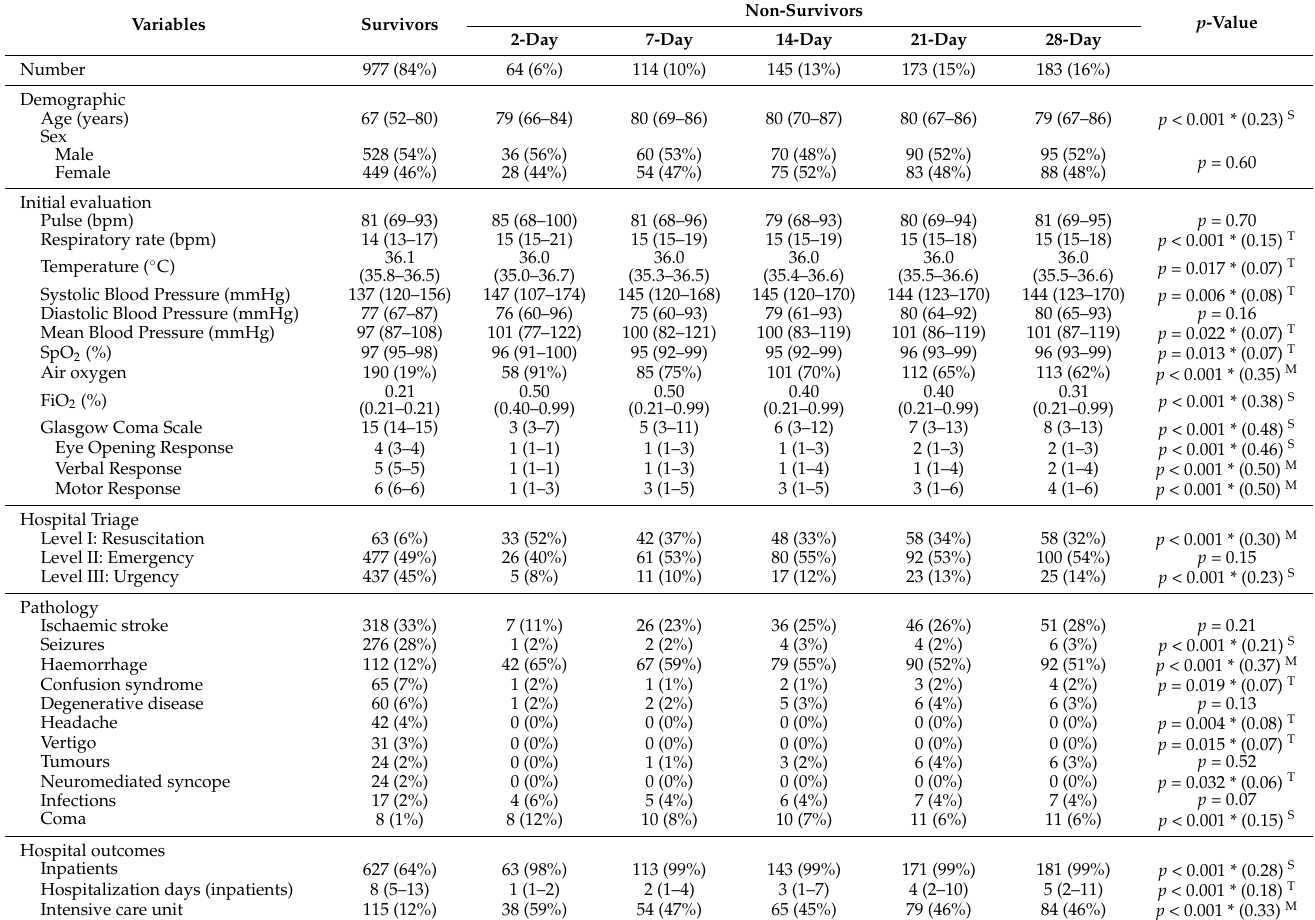
Table 2. Comparison of patient variables recorded in the emergency department according to 2-, 7-, 14-, and 28-day